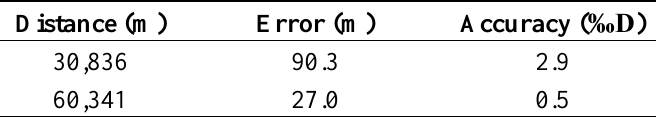
Table 8. On-line experimental results in Experiment